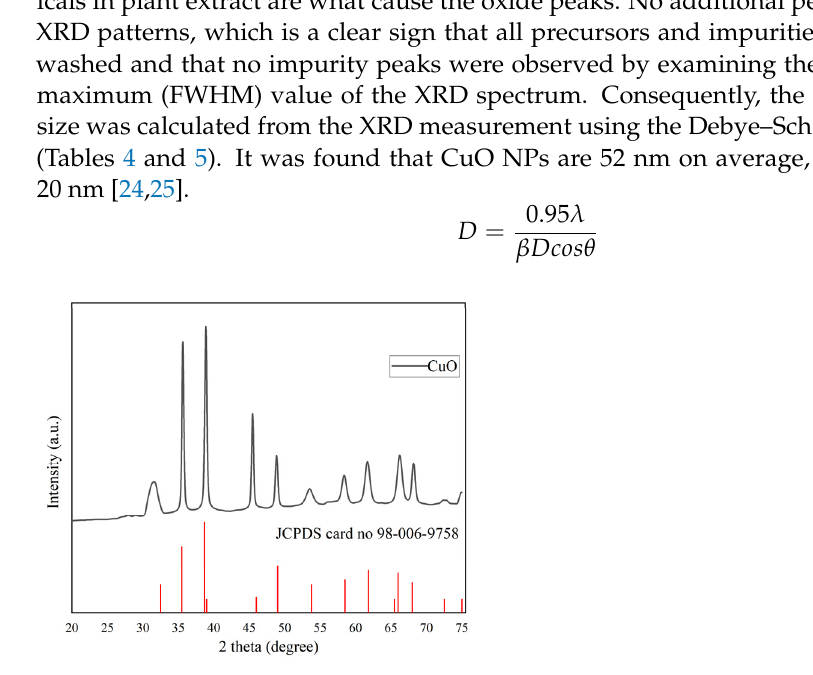
Figure 7. X-ray Diffraction of ZnO NPs. 3.4. Nanofluid Stability The colloidal stability of nanoparticles was studied by using the visual method. The main goal is to observe for any sedimentation. Copper oxide nanofluid was prepared at 100, 200, 300, and 700 ppm, as mentioned before, and observed for 1 h and 24 h. For the first hour, the nanofluid remained stable and no sedimentation was observed, while after 24 h, some sedimentation was observed for both ZnO and CuO (Figure 8c).